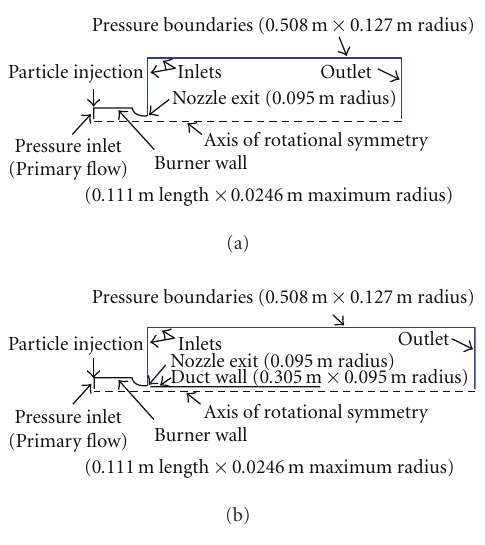
Figure 3: Diagram with dimensions and boundary conditions for (a) unducted burner-erosion rig; (b) a ducted burner-erosion rig.